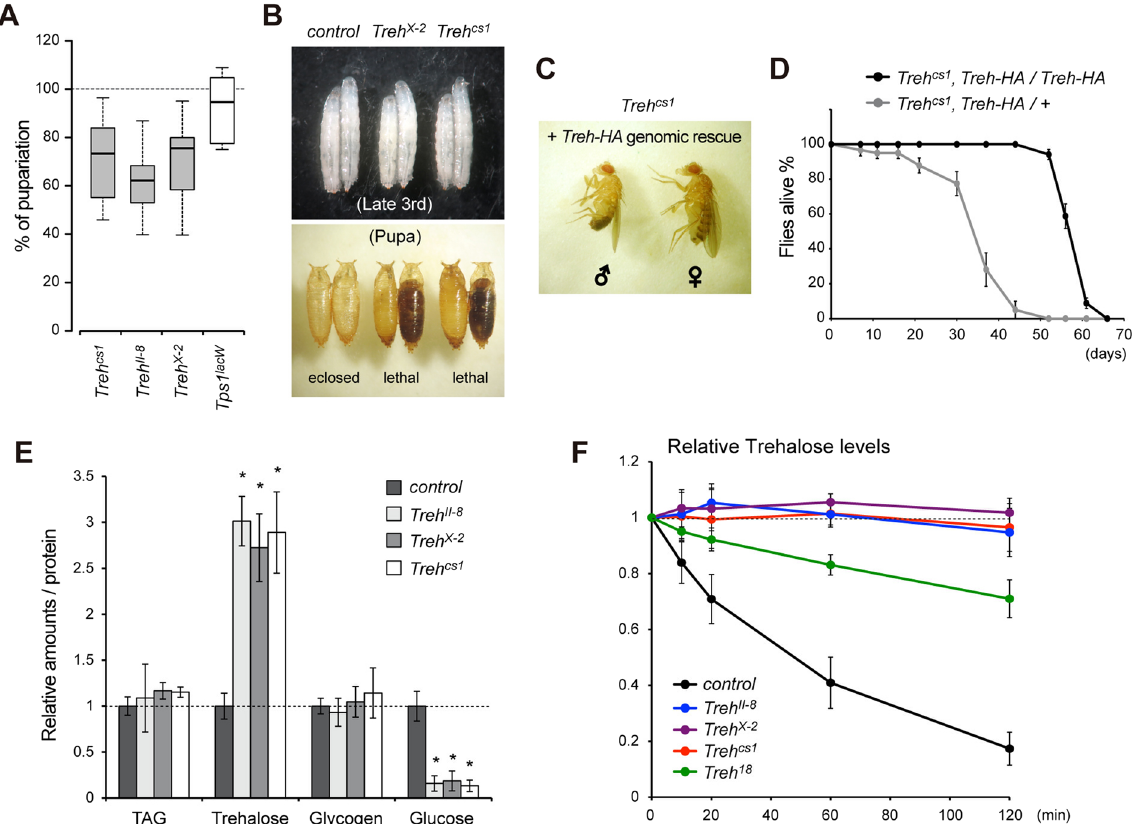
Figure 3. Treh II-8 and Treh X-2 mutants are indistinguishable from Treh cs1 mutants. ( A ) The majority of Treh II-8 and Treh X-2 mutants are lethal at the pupal stage. Percentages of homozygous mutant pupae were determined by the ratio to heterozygous mutants in each vial. No statistical significances were detected by one-way ANOVA with Tukey’s post hoc test (p < 0.01). n = 6. ( B ) Treh X-2 and Treh cs1 mutants at late-third larval and pupal stages are shown. ( C ) One copy of the genomic rescue construct of Treh-HA rescues the pupal lethality of Treh cs1 homozygous mutants. ( D ) Survival of male flies with one copy or two copies of the genomic rescue constructs of Treh-HA in a Treh cs1 homozygous mutant background. Values shown are means and SEM. n = 4. ( E ) Treh II-8 and Treh X-2 mutants exhibit the identical phenotype to Treh cs1 , as revealed by the increase in trehalose levels and decrease in glucose levels in late third instar larvae. Each value was normalized by protein levels and further normalized according to the levels in the control larvae. ( F ) Trehalase activity was measured in larval homogenates. Relative levels of trehalose are shown for each mutant. Values are means and SD. n = 4 ( E , F ). * p < 0.01; one-way ANOVA with Dunnett’s post hoc